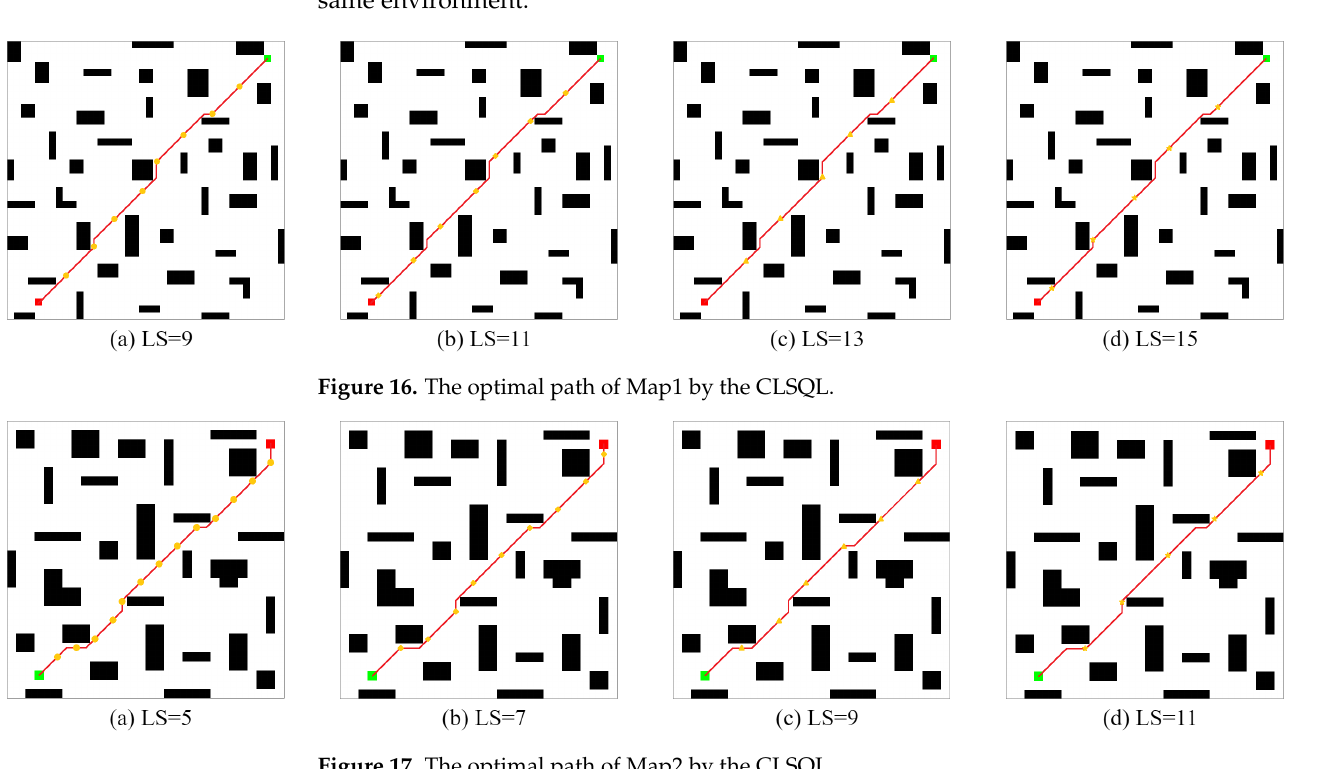
Figure 17. The optimal path of Map2 by the